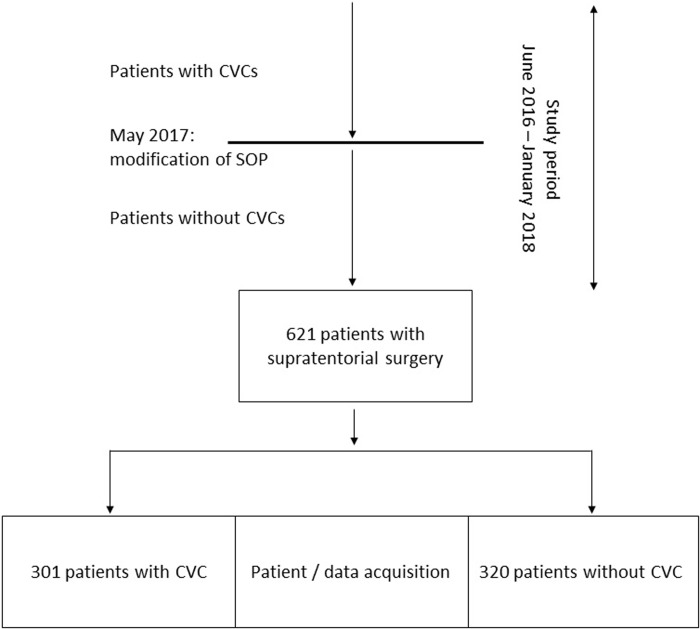
Patient / data acquisition.Retrospective data acquisition was performed between June 2016 and January 2018. Standard anaesthesia procedures were modified during the study period resulting in the termination of obligatory CVC instrumentation for supratentorial procedures. CVC: central venous catheters; SOP: Standard Operating Procedure.